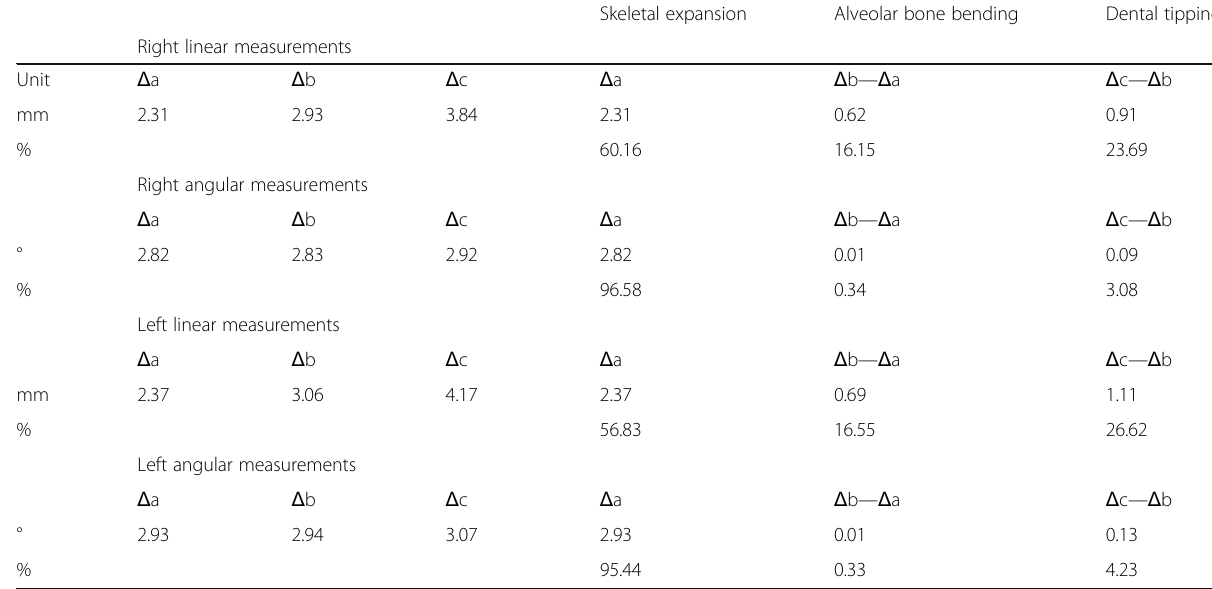
Table 3 Linear and angular treatment change measurements for each component Skeletal expansion Alveolar bone bending Dental tipping